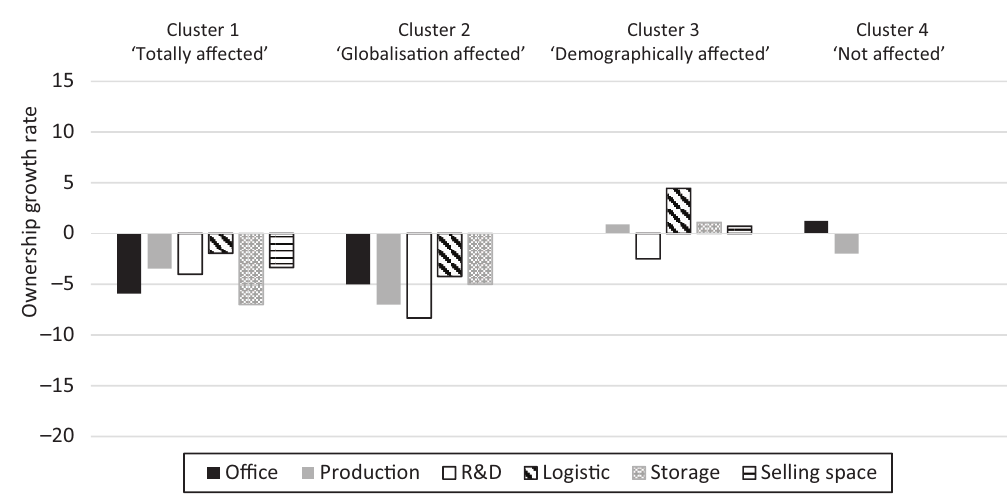
Figure 5. Ownership growth rates by structural change situation and use